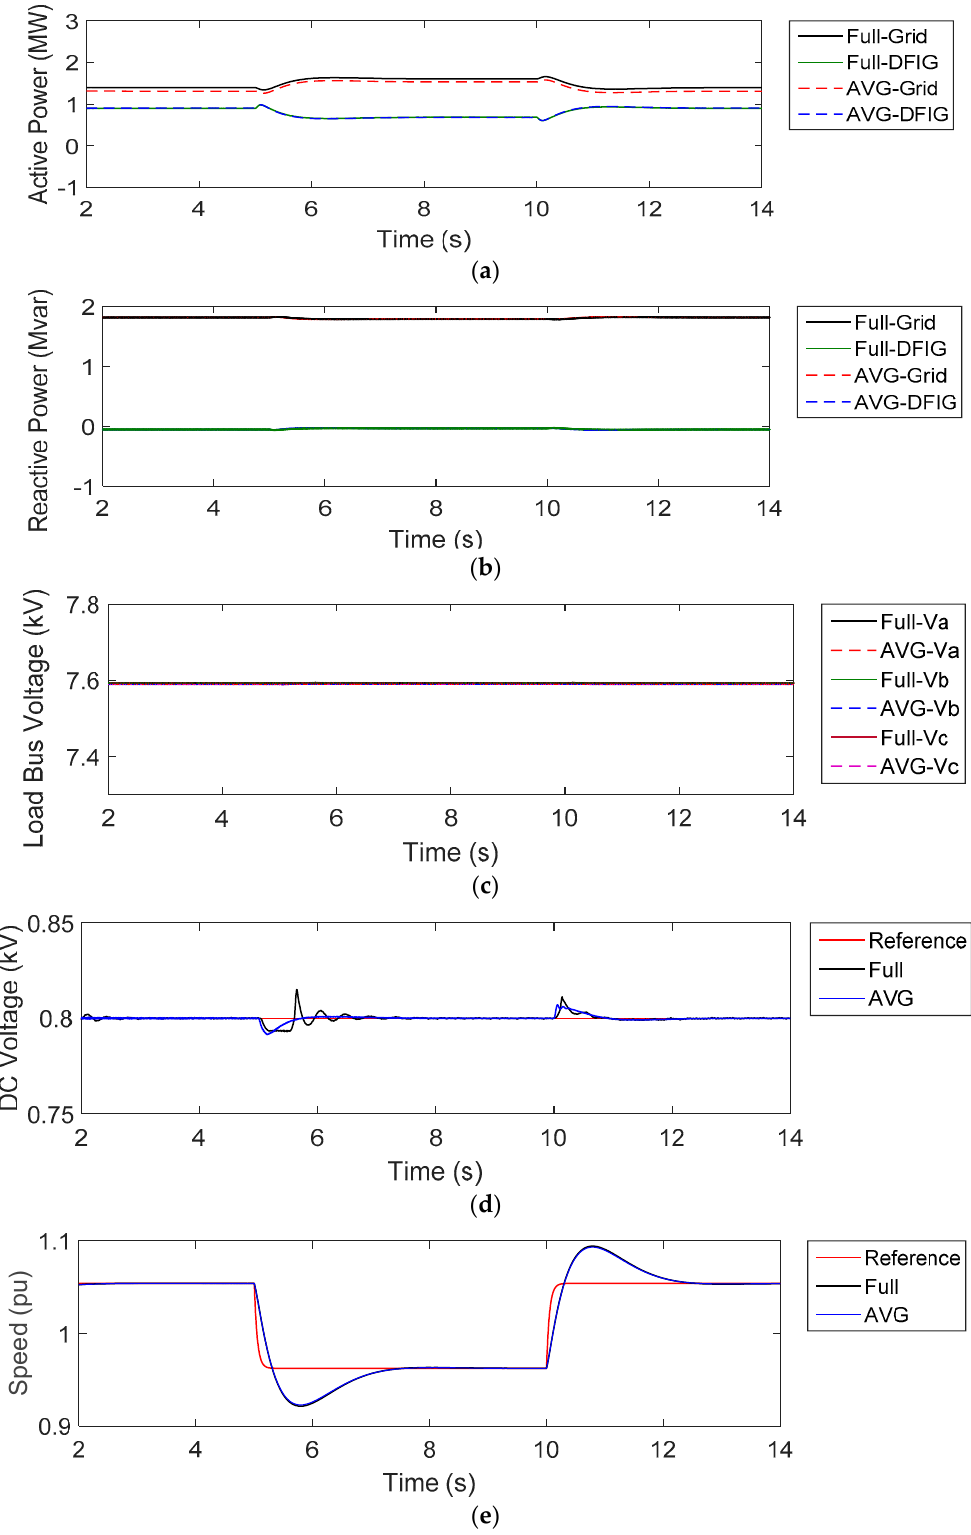
Figure 10. Outputs when wind speed change of 11.5 m/s to 10.5 m/s back to 11.5 m/s with balanced loads connected to DFIG Bus: ( a ) active power outputs, ( b ) reactive power outputs, ( c ) load bus voltage, ( d ) DC voltage, ( e ) DFIG speed.